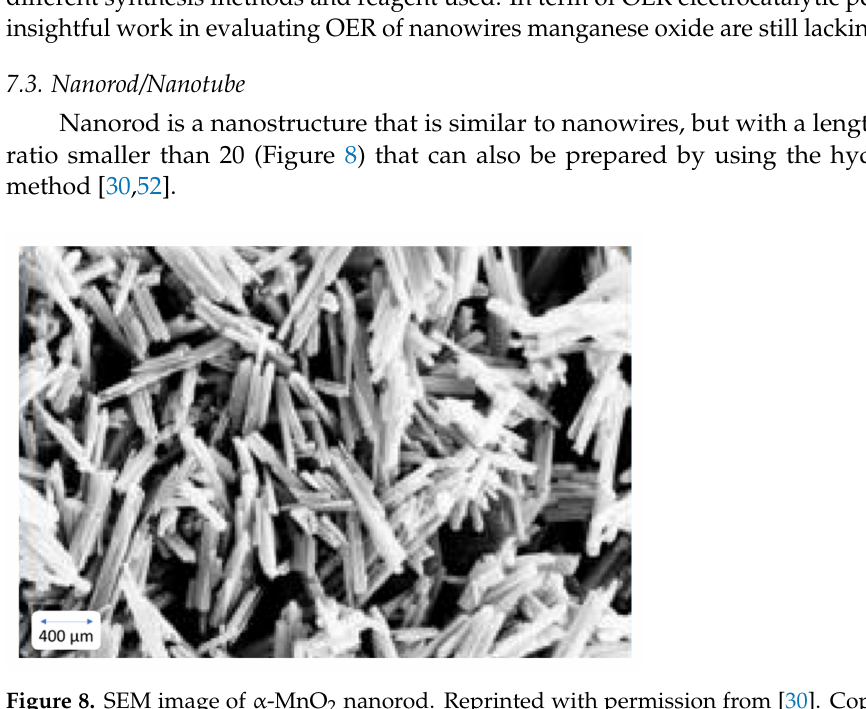
Figure 8. SEM image of α -MnO 2 nanorod. Reprinted with permission from [30]. Copyright 2015 American Chemical